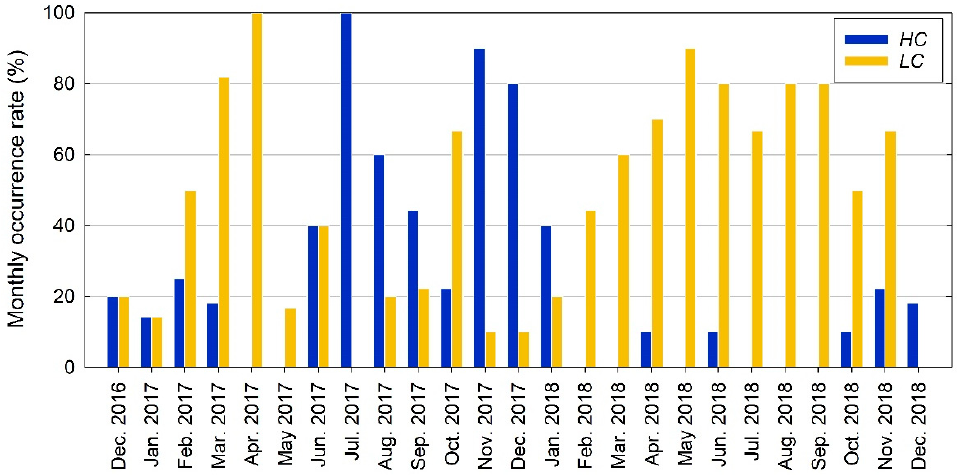
Figure 4. Monthly occurrence rates of higher concentration ( HC ) and lower concentration ( LC ) samples throughout the sampling